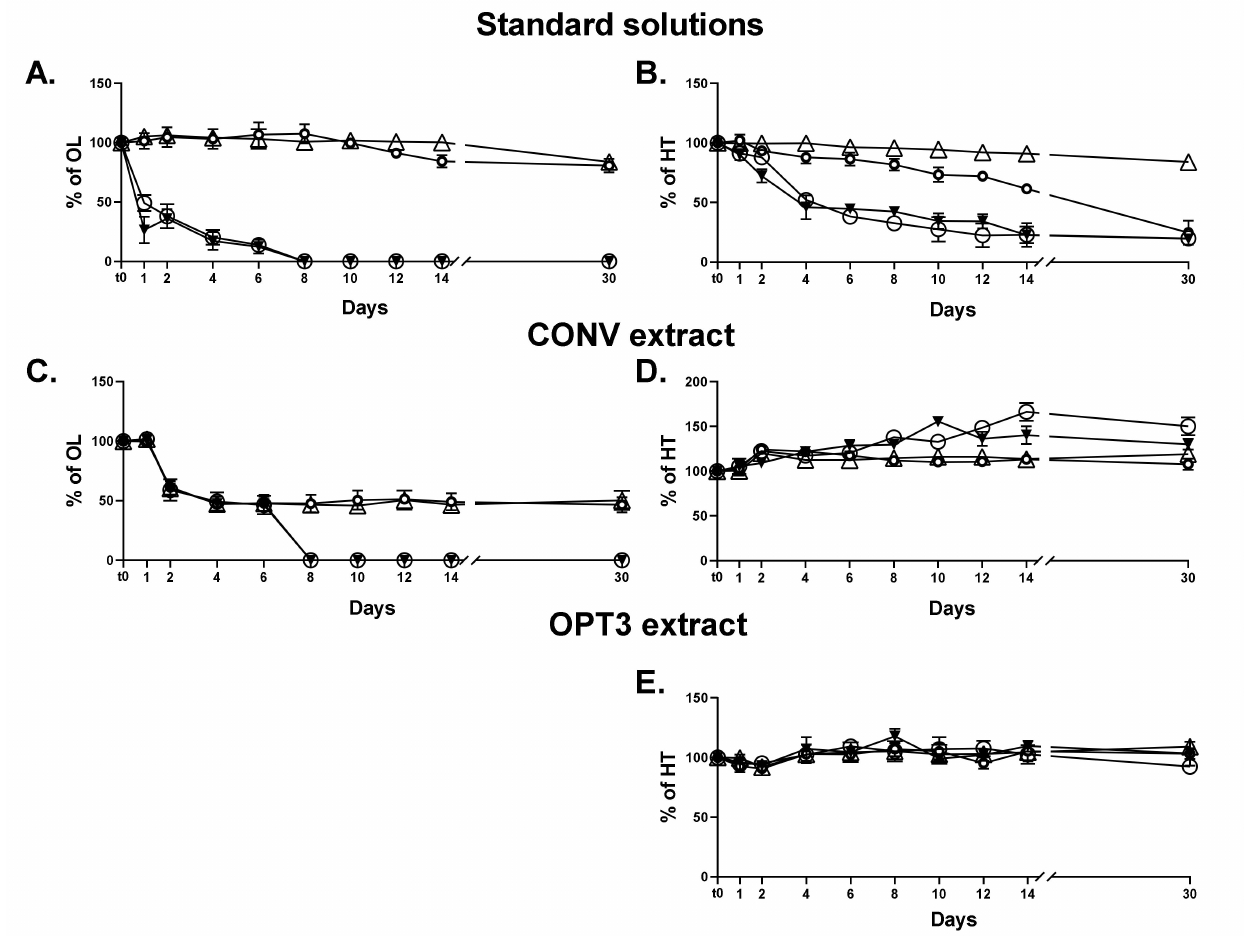
Figure 3. Stability studies up to 30 days of aqueous solutions of oleuropein (OL) standard ( A ), hydroxytyrosol (HT) standard ( B ), OL ( C ), and HT ( D ) in conventional (CONV) extract, and HT ( E ) in optimized (OPT3) extract at four different conditions of temperature (T) and relative humidity (RH). Results are presented as average of percentage of each compound (HT or OL) with respect to the initial quantity of t 0 ± standard deviation (SD). Lines are added to guide the